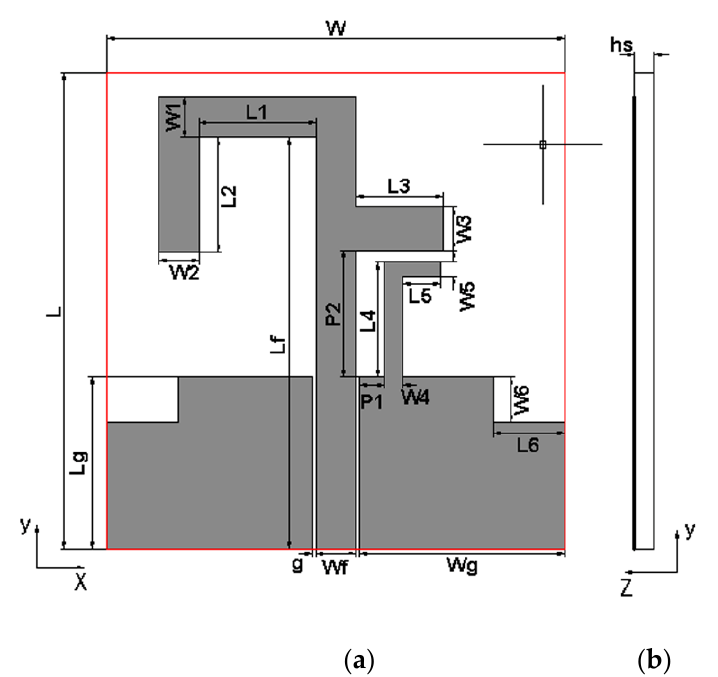
Figure 1. The geometry of the proposed monopole antenna. ( a ) Front view. ( b ) Side view. Table 1. The dimensions of the monopole antenna and EBG unit.